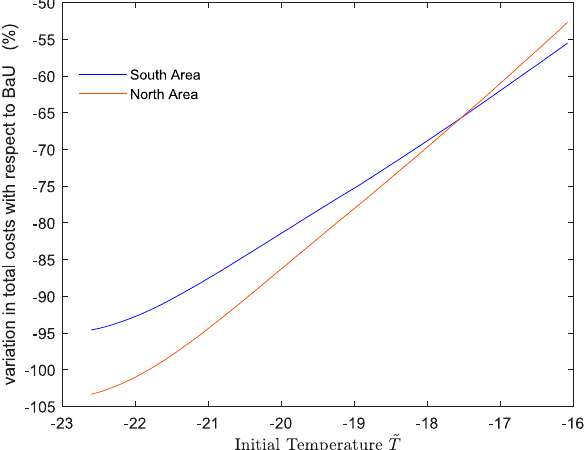
Figure 8. Percentage variation of the total cost (18) achieved with the proposed DCS with respect to the Business as Usual (BaU).